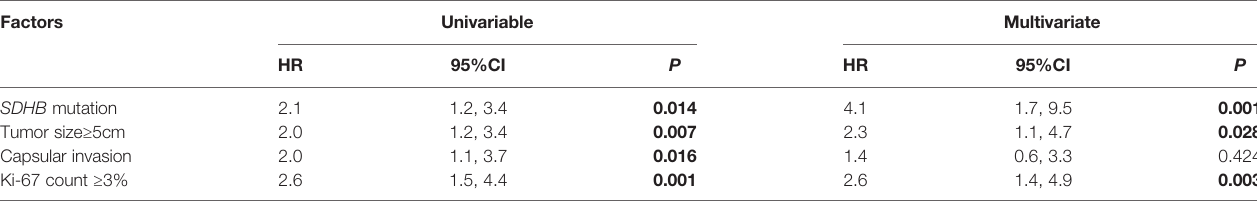
TABLE 2 | Hazard ratios for the risk of recurrence of pheochromocytoma/paraganglioma. Factors